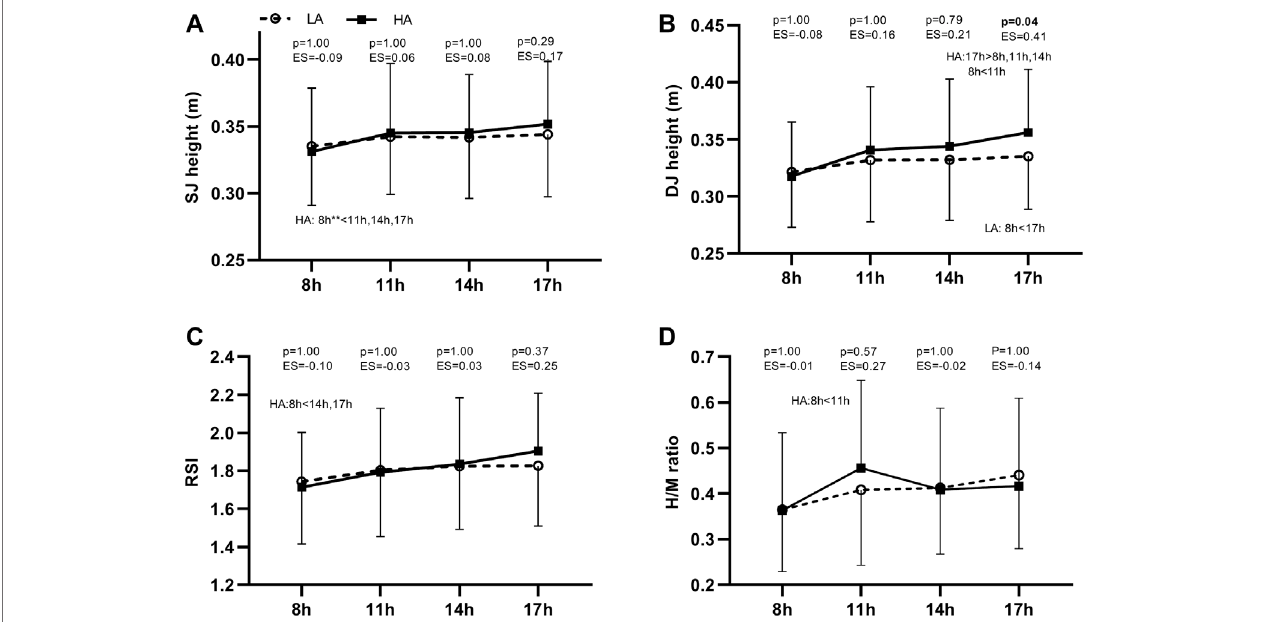
FIGURE1| Comparison SJheight (A) ,DJheight (B) ,RSI (C) ,and H/Mratio (D) betweenthelowaltitude(LA;opencircle, dashedline)andhigh altitude(HA;black square, solid line) conditions at the different points of measurement. SJ, squat jump; DJ, drop jump; RSI, reactive strength index; H/M ratio, ratio between the peak-to- peak amplitude for the H-re fl ex and M-wave; ES, Cohen ’ s d effect size [(mean HA – mean LA)/SD both]; **, signi fi cant differences (p < 0.05) between the points of measurement. Data are depicted as means and standard deviations.